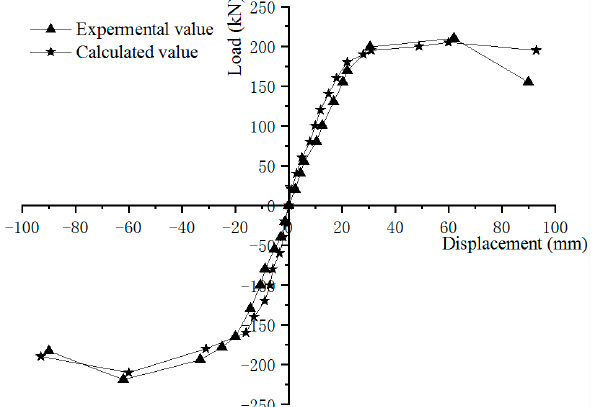
Figure 20. The comparison between the KJ-3 curve and the curve of the finite element analysis.